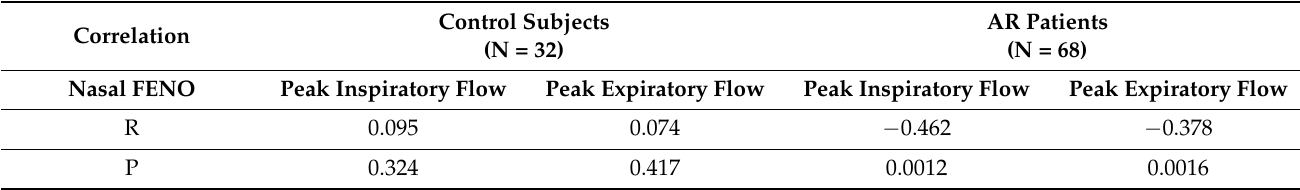
Table 3. Correlation between nasal FENO and nasal peak flow of study subjects.